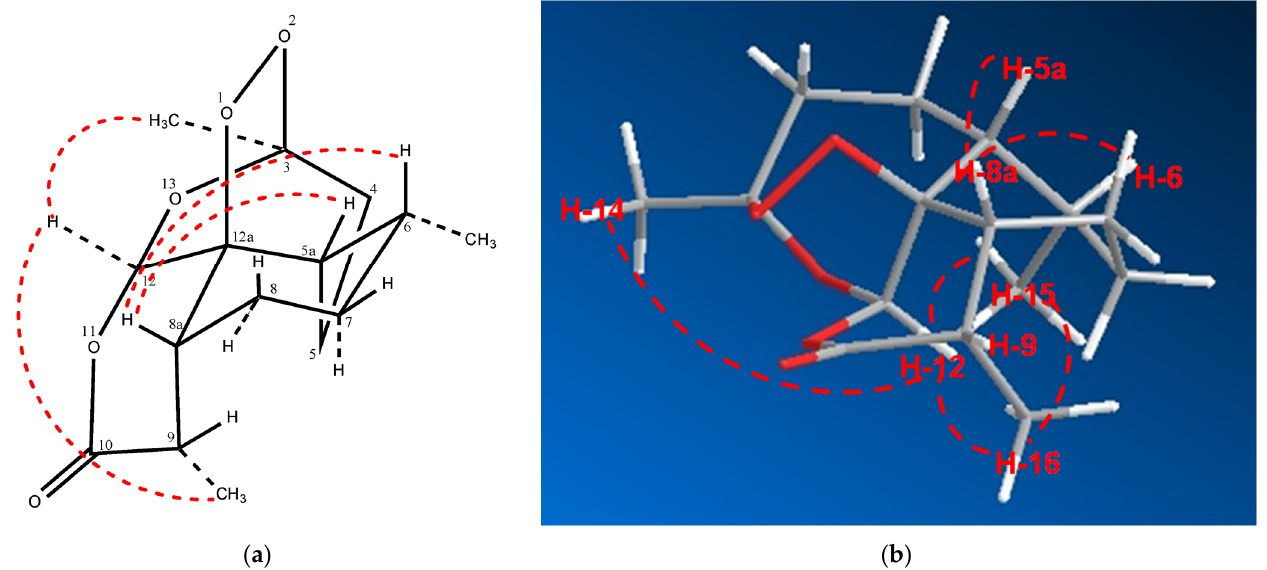
Figure 3. Selected ROESY cross peaks for ( − )-6-epi-artemisinin ( 2 ): ( a ) 3D structure drawing; ( b ) 3D model by chemBioDraw Ultra